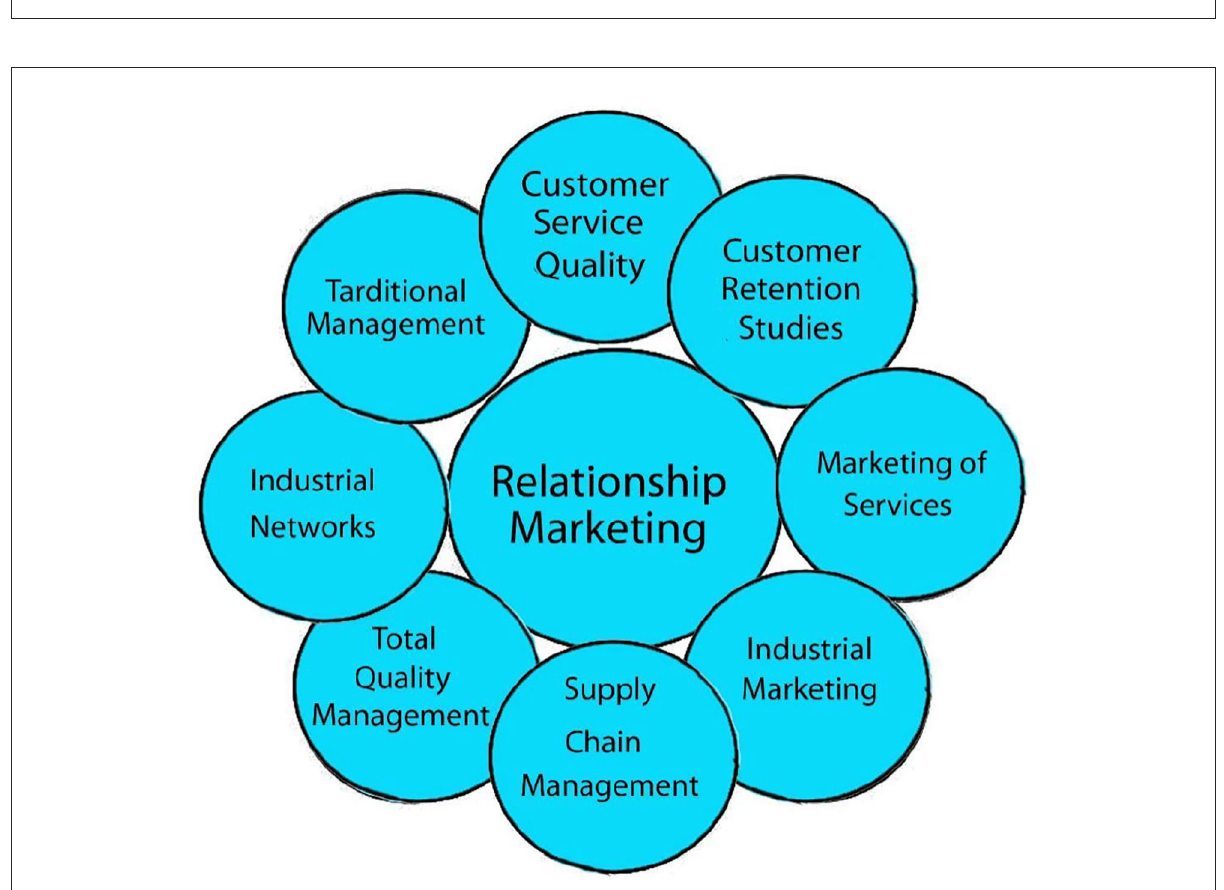
FIGURE11 Relationship creative’s primary